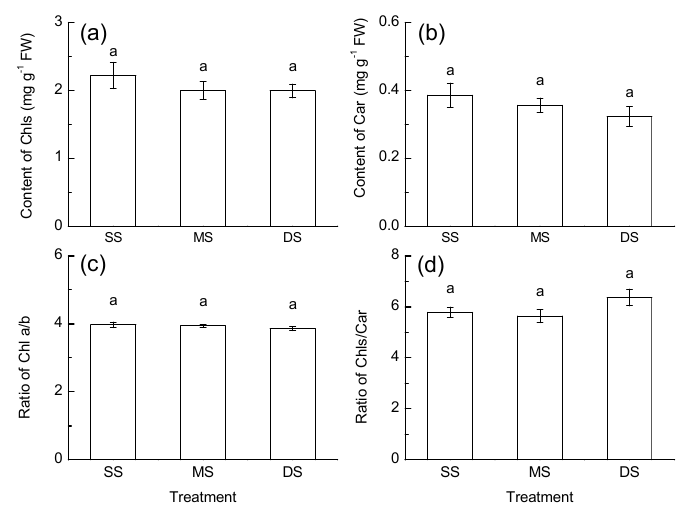
Figure 3. Chlorophylls (Chls) content ( a ), carotenoid (Car) content ( b ), ratio of chlorophyll a/b (Chl a/b) ( c ) and ratio of chlorophylls/carotenoid (Chls/Car) ( d ) of S. matsudana under shallow submergence (SS), moderate submergence (MS) and deep submergence (DS) treatment in the hydro-fluctuation zone of the TGDR. Different letters on each bar represent significant difference among treatments at the 0.05 level. Values are means ± standard error ( n = 9).